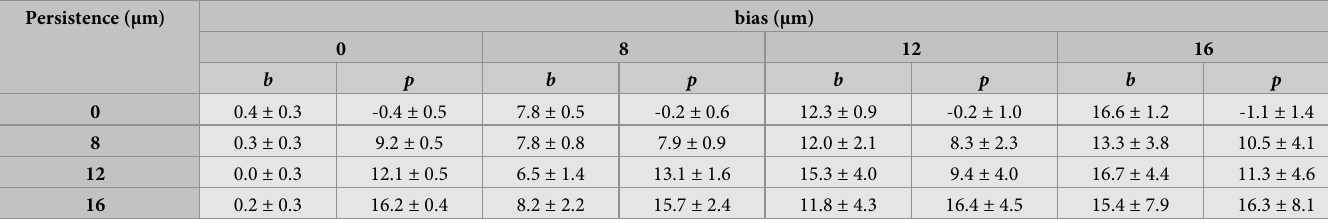
vectors were also tested for a second simulated set of populations characterized by a larger value of random module (12.5 μ m/40 min) and also in this case the obtained values show good correspondence with the expected ones, thus proving that the efficacy of the analysis method is not impaired by changes in the random module (S2 Table). Calculated random vectors pro- duced for each population an average module close to the one used as input (S3 Table). In order to evaluate the performance of the model in relation to cell population size, the previous analysis was repeated using datasets of size ranging between 10 and 100 cells. The results (S2 Fig) show that for both bias and persistence values, calculated/expected ratios are within ± 0.4 for datasets of 10 to 20 cells but quickly go down to smaller ones for 30–50 cells and are reduced to within ± 0.1 for bigger datasets (100 cells). In addition, median values, which are very variable for 10 and 20 cells, starting from 30 cells, i.e. the population sizes used in our evaluations, become less variable and closer to the expected values. ness in separating bias and persistence components also with experimental populations. The results are reported in Table 3 as random, persistence and bias vector modules for a 40 minute time interval; for wound healing experiments, angle δ , i.e. the angle between bias vector and expected migration direction, is also reported. For all cell lines, in absence of wound stimulus, the detected bias has values close to zero and movement, as might be expected, is essentially determined by random and persistence module. Cells with larger average distances show cor- respondingly higher values for both the random and the persistence module. For all cell lines, the introduction of a wound stimulus results in a modified movement pattern, characterized by a bias vector of considerably higher module than that observed in absence of wound for the same cell lines and oriented along the expected direction, i.e. towards the empty space left by the wound, as indicated by δ angle values ranging between 2 and 43 degrees.